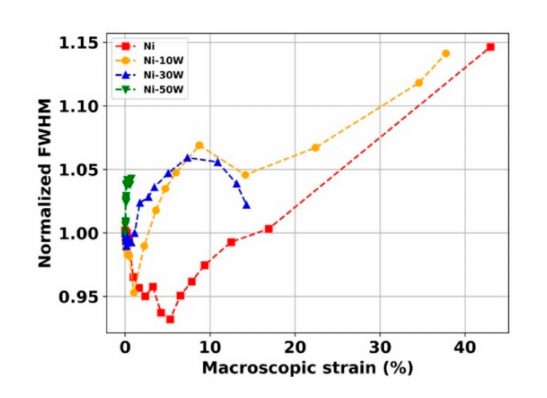
Figure 6. Normalized FWHM of the Ni {111} and Ni(W) {111} as a function of the macroscopic strain of the bulk Ni and Ni-W